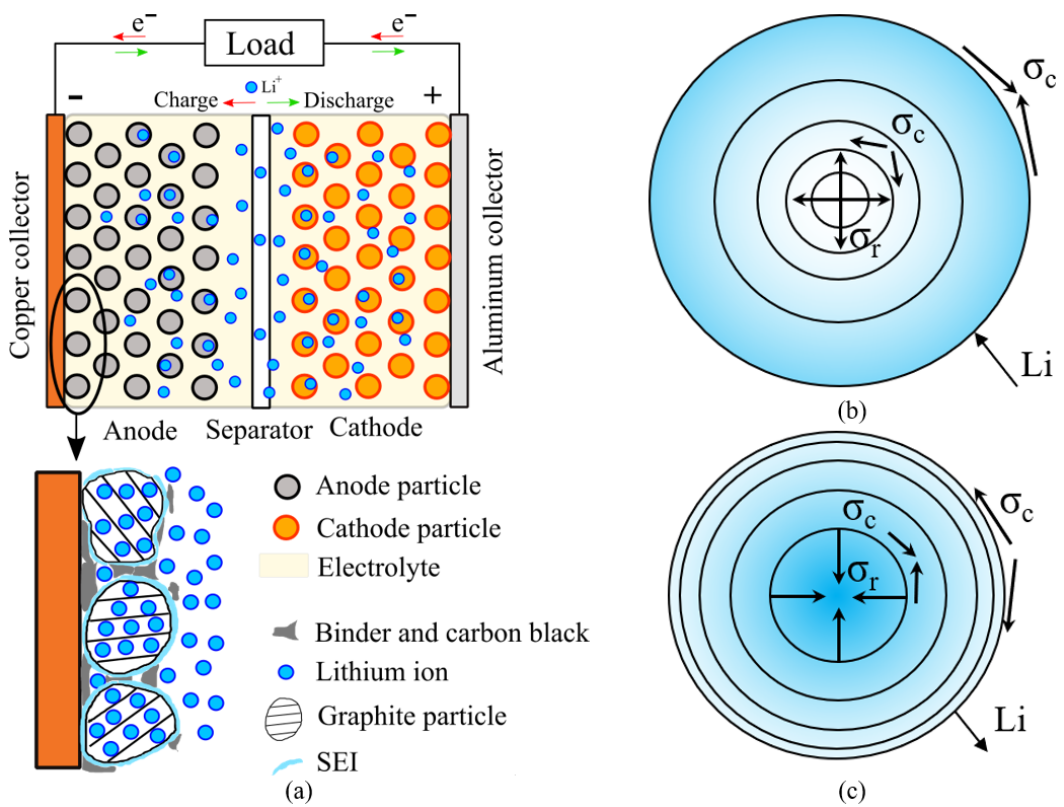
Figure 1. Battery scheme at micrometer scale and focus on the lithium intercalation mechanism in anode particles ( a ). Stress and deformation of the active material particles during lithium insertion ( b ) and extraction ( c ). Blue shadows depict the lithium concentration (blue means high concentration, white means low concentration). Concentration level affects tension (arrows pointing toward each other) and compression (arrows pointing away from each other) of radial and hoop stress. The concentric lines show expansion or shrinking of the particle: they are evenly spaced in the undeformed